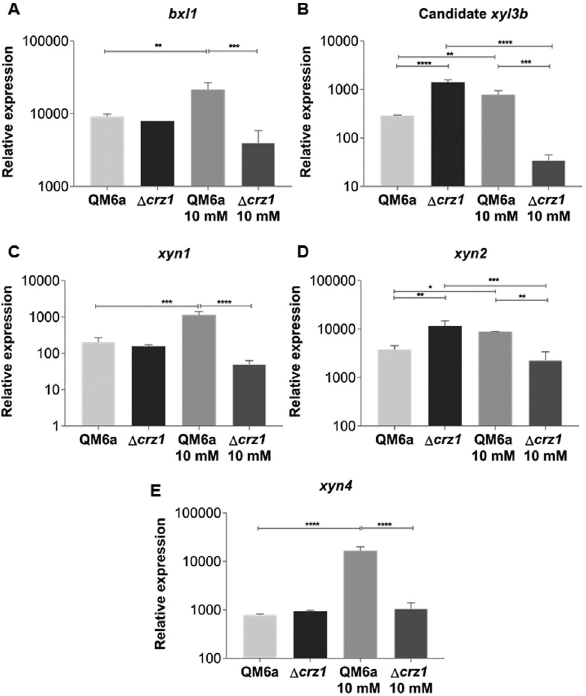
Figure 3 - Relative expression of the (cid:6) -xylosidase 1 and (A) the candidate xyl3b xylosidase(B)andoftheendoxylanases xyn1 (C) ,xyn2 (D)and xyn4 (E) genes from QM6a and (cid:2) crz1 T. reesei strains after 8 h of induction SCB and SCB supplemented with 10 mM Ca 2+ . Expression values are rep- resented as log 10 means of three biological replicates with standard devia- tion normalized by glycerol expression levels at the same condition. Sta- tistical significance is represented as asterisks, considering p-value as <0.05 (*), <0.01 (**), <0.001 (***) and p<0.0001 (****).